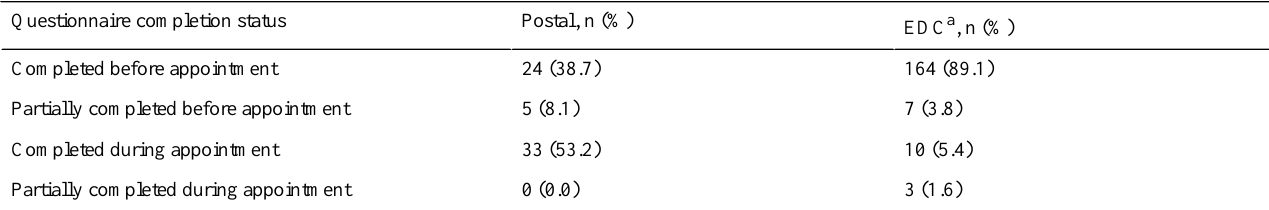
Table 1. Questionnaire response rates for the postal (N=62) and EDC (N=184) groups.